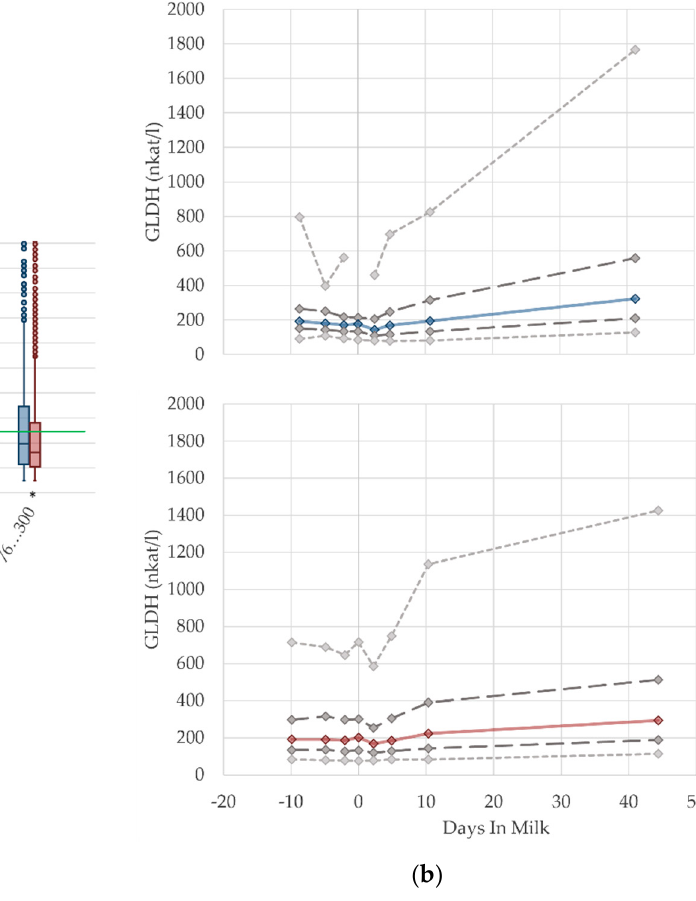
Figure 8. Serum activities of glutamate dehydrogenase (GLDH) in primiparous (blue) and in multiparous (red) cows ( a ) in 10 classes between 30 days prepartum to 300 days postpartum (boxplots), green continuous lines represent the reference values according to Fürll [23], asterisk indicates significant differences regarding parity within DIM class; and ( b ) in 8 classes from 10 days prepartum to 40 days postpartum (median—continuous line; 1st and 3rd quartile—dashed lines; percentile 5 and 95—dotted lines).